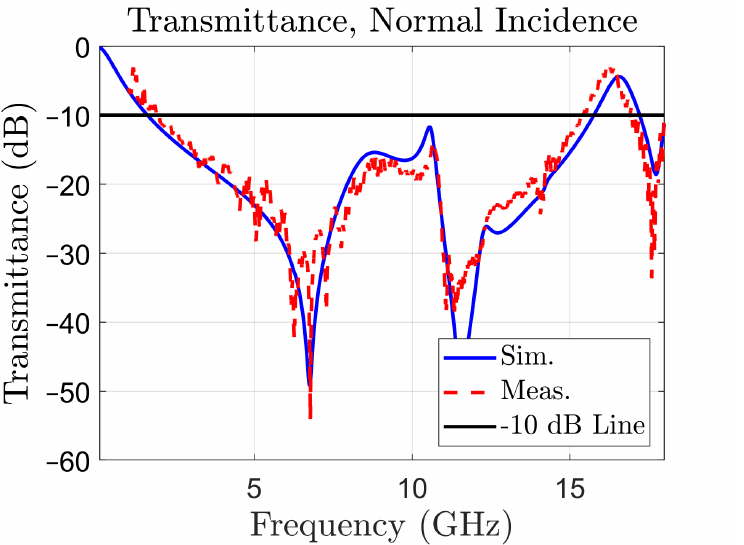
Figure 2. Transmittance of the periodic surface in normal incidence: simulated (blue, solid line), and measured (red, dotted line). The –10 dB line is used to determine